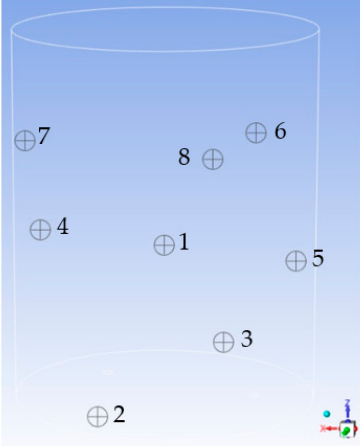
Figure 10. Monitoring point in the mathematical modelling. Ponit1 (0, 0, and 200 mm), Ponit2 (70.8, 170.9, and 20 mm), Ponit3 ( − 70.8, − 170.9, and 20 mm), Ponit4 (170.9, − 70.8, and 200 mm), Ponit5 ( − 170.9, 70.8, and 200 mm), Ponit6 ( − 117, 0, and 350 mm), Ponit7 (170.9, 70.8, and 350 mm), Ponit8 ( − 70.8, 170.9, and 350 mm).